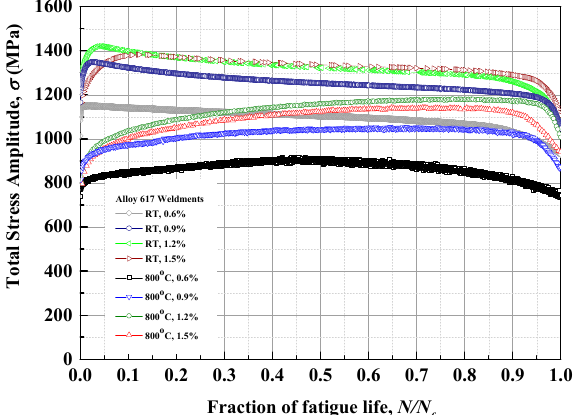
Figure 4. The normalizing fatigue life on cyclic stress response regarding to four total strain ranges of Alloy 617 weldments at room temperature and 800 °C.